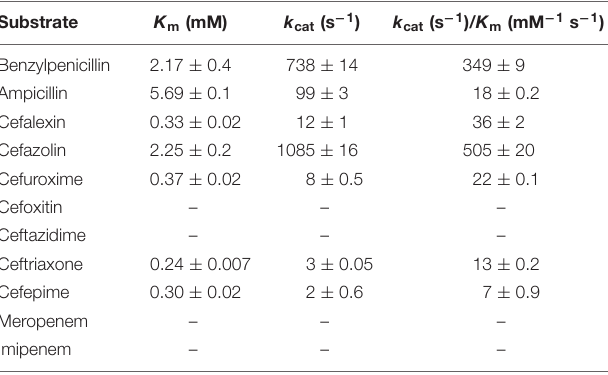
TABLE 2 | Steady-state kinetic parameters for hydrolyses of β -lactam substrates by the native CzoA.